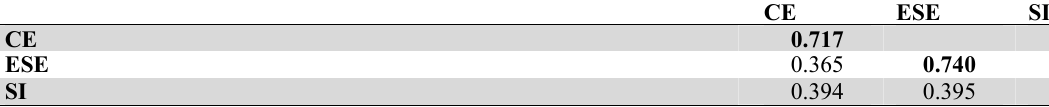
Discriminant validity